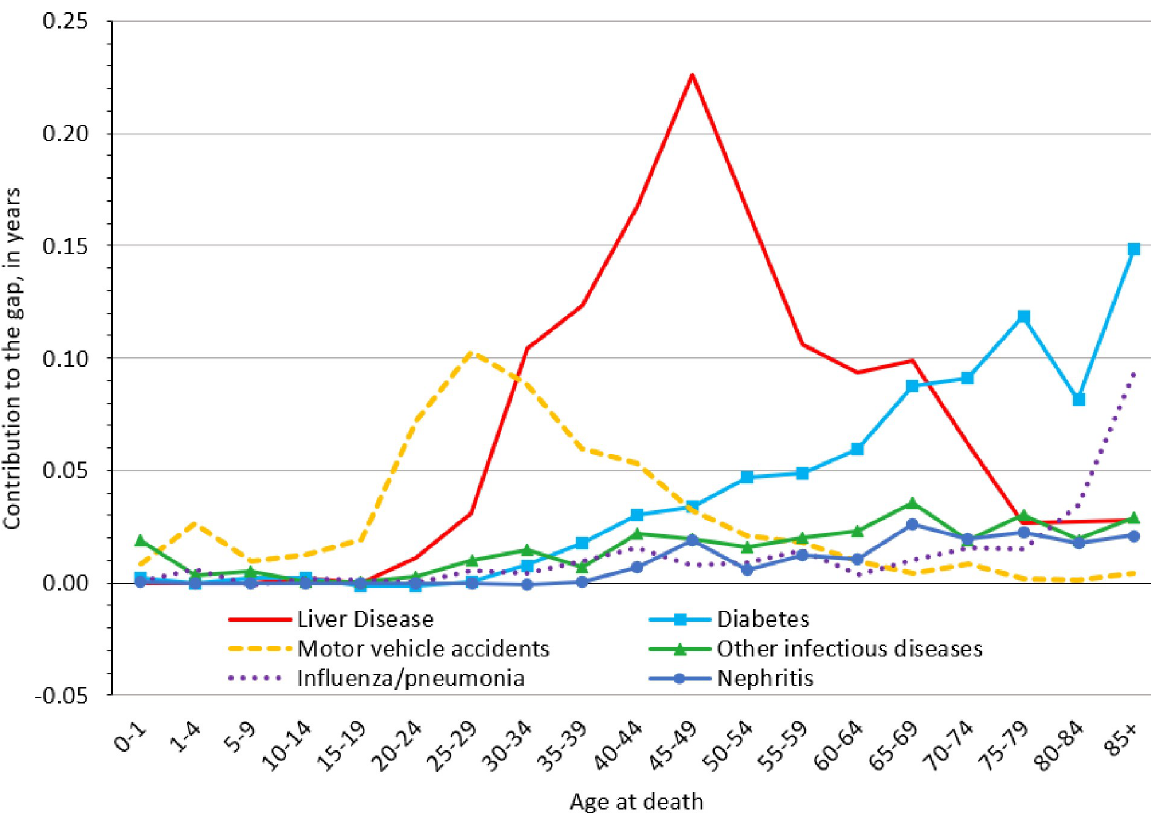
Fig 3. Native American-White life expectancy gap in the Four Corners States among females, 2015. The life expectancy gap was decomposed into various causes of death at specific ages. Estimates for 2015 represent a 5-year aggregation of data (i.e., 2013–2017).